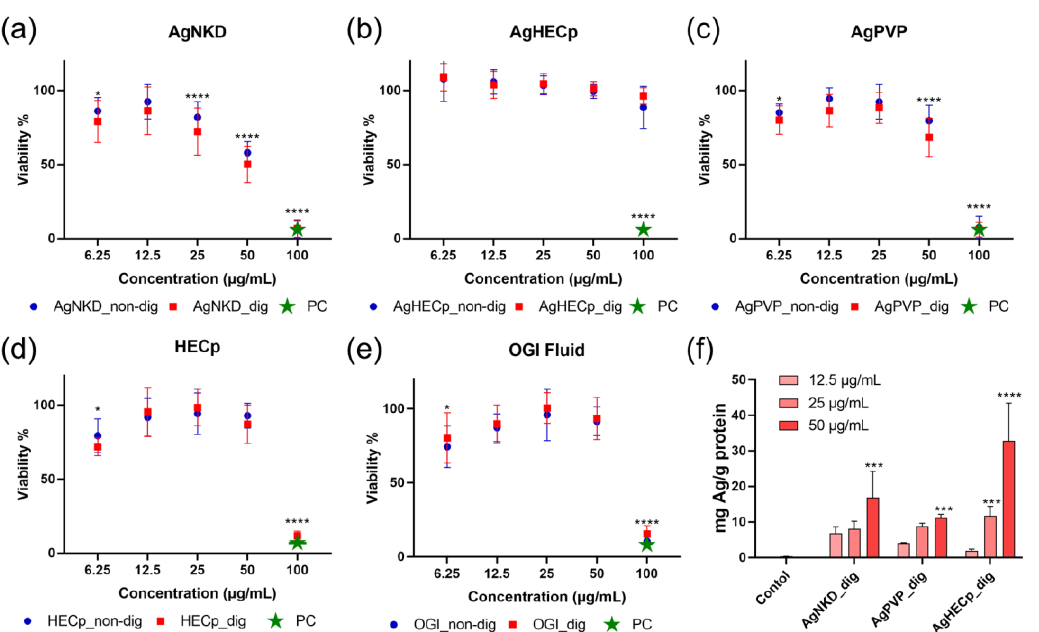
Figure 3. Impact of non-digested and digested Ag NMs on HCT116 cell viability. Cell viability assessed by WST-1 assay 24 h after HCT116 cells were exposed to digested and non-digested Ag NPs ( a – c ), as well as HEC (no Ag) ( d ) and OGI fluid (no NMs) ( e ). PC refers to the positive control, i.e., amino-modified polystyrene nanoparticles (PSNH2) used at 100 µg/mL. Ag intracellular accumulation ( f ). HCT116 cells were exposed for 24 h to AgNKD, AgPVP and AgHEC, and intracellular Ag content was measured using ICP-MS. Values are the mean ± SD of three independent experiments with five replicates per experiment. Statistical significance, exposed vs. control, (*) p < 0.05, (***) p < 0.001, (****) p < 0.0001.